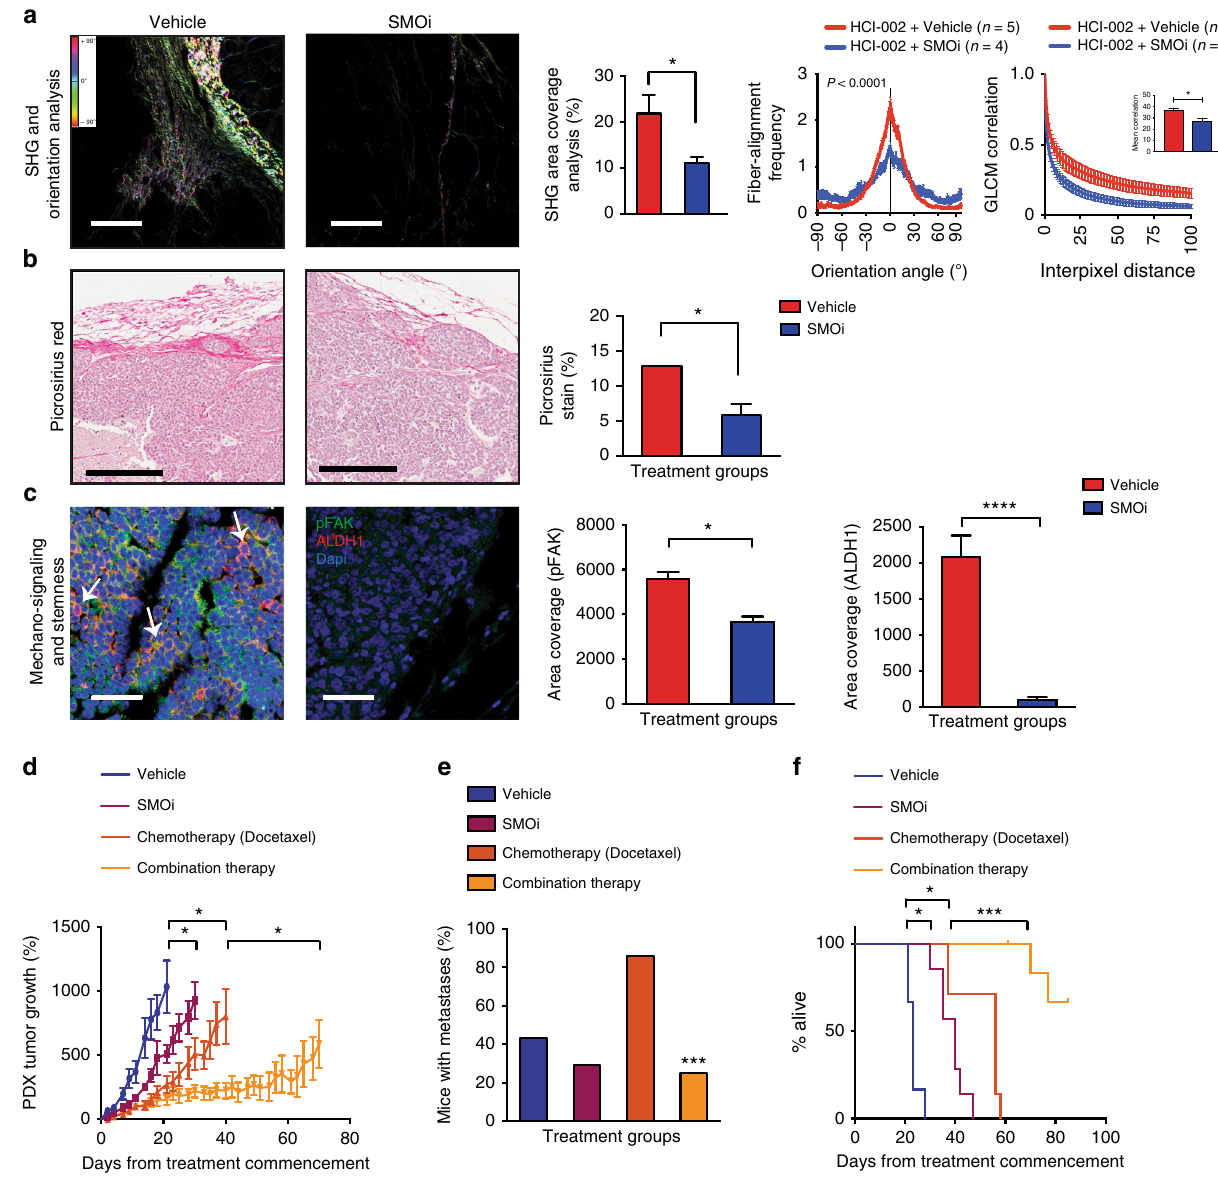
Fig. 6 Ef fi cacy of long-term SMOi-combined therapy in preclinical models. a – c Concomitant expression analysis of collagen content and organization, integrin pathway activation and CSC-like characteristics at the tumor − stromal interface of the TNBC HCI-002 PDX model treated with vehicle (red) or the SMO inhibitor NVP-LDE225 (80 mg/kg/day; blue) ( n = 5 biological replicates). a Representative imaging (scale bars: 100 μ m) and quantitative analysis of collagen abundance (left panel). Statistical signi fi cance was determined using unpaired two-tailed Student ’ s t test with equal s.d. Corresponding graphs comparing fi ber orientation (middle) and quantifying GLCM analysis (right panel) in the vehicle and SMOi-treated models. Unpaired two-tailed nonparametric Mann – Whitney U test was used for determining statistical signi fi cance across distributions. b Collagen I and III deposition detected and quanti fi ed by picrosirius red staining. Scale bars, 200 μ m. Statistical signi fi cance was determined using unpaired two-tailed Student ’ s t test with equal s.d. c Representative immuno fl uorescence images and quanti fi cation of concomitant phospho-FAK (green) and the human CSC marker ALDH1 (red) expression in the HCI-002 model. The white arrows illustrate examples of co-staining within the epithelial population. Scale bars, 100 μ m. n = 3 biological replicates. Statistical signi fi cance was determined using Kruskal − Wallis test. d – f TNBC HCI-002 PDX model treated with vehicle (blue), SMO inhibitor (NVP-LDE225; 80 mg/kg/day; magenta), chemotherapy (docetaxel; 15 mg/kg/week; dark orange) or NVP-LDE225 (80 mg/kg/day) + docetaxel (15 mg/ kg/week; orange line) ( n = 7 mice per treatment group). d Tumor growth curves. Statistical signi fi cance was determined using unpaired Student ’ s t test. e Percentage of mice with detectable metastases in the lung, liver, and axillary lymph node in each treatment group. Statistical signi fi cance was determined using the Fisher ’ s exact test. f Kaplan − Meier curves of mice overall survival of each treatment group. Statistical signi fi cance was determined using Log- rank test of NVP-LDE225 + docetaxel vs. docetaxel; * P < 0.05; *** P < 0.001; **** P < 0.0001. Bars on the graphs represent mean ±